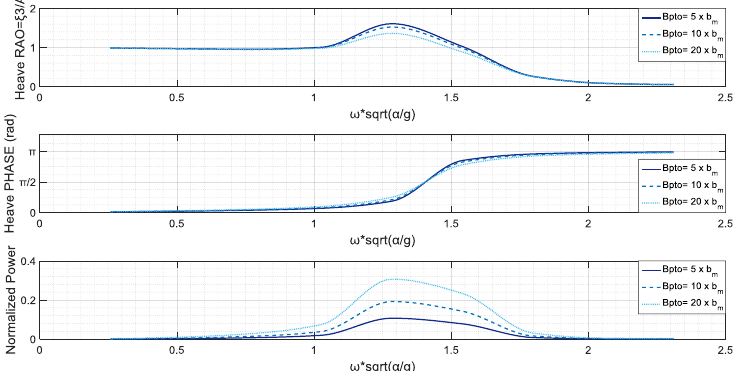
Figure 9. Heave RAO, Phase RAO and Normalized Power Output-Nailhead-shaped WEC.